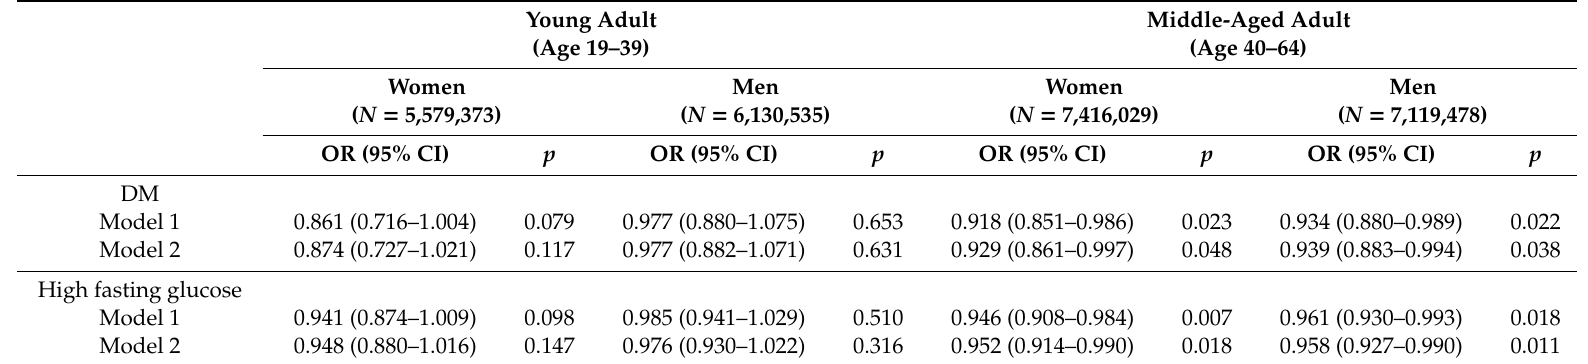
Table 5. Risk of prevalent diabetes according to the amount of co ff ee consumption after adjustment for